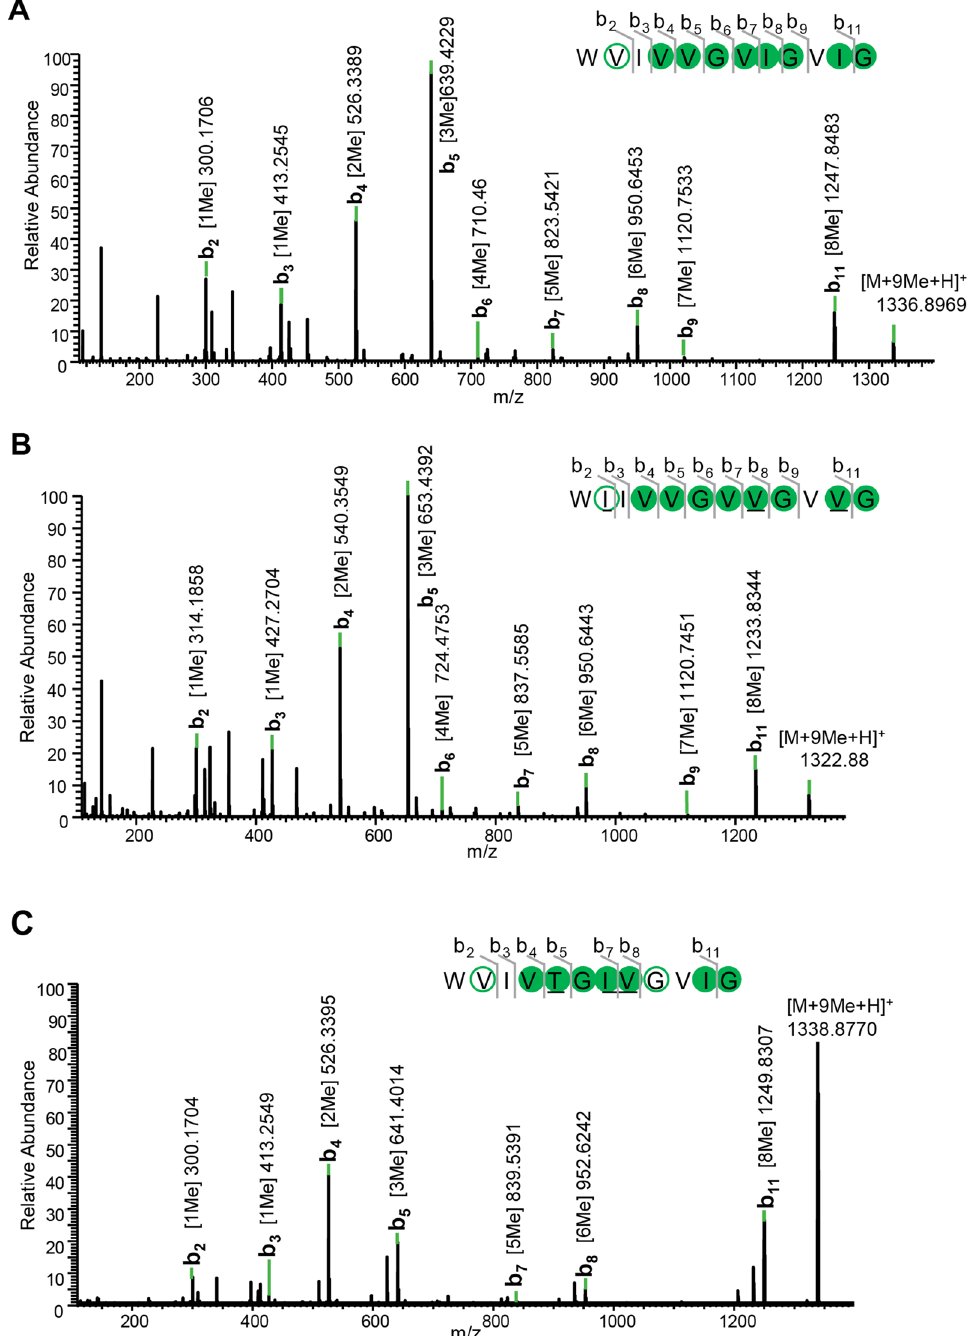
Figure 3. Annotated LC–MS/MS spectra of fully methylated, linear core peptides of omphalotin A, lentinulin A and dendrothelin A produced in P. pastoris . The peptide sequence of each peptide is presented together with the corresponding b-ions. The confirmed positions of methylation are depicted using filled circles, while methylated residues inferred from MS are shown in open circles. Residues different from omphalotin A are underlined. Annotated LC–MS/MS spectra of (macrocyclic) omphalotin A, lentinulin A and dendrothelin A are provided in Supplementary Fig.